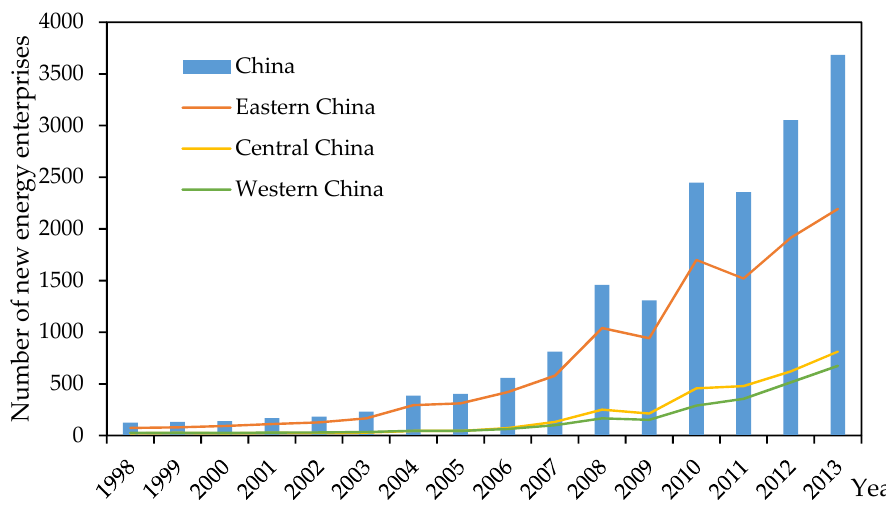
Figure 2. Number of new energy enterprises in China from 1998 to 2013. Based on sample data, we explored the spatial distribution characteristics of the five driving factors across China in 2013 (see Figure 3). There are significant regional disparities in these factors. (1) Enterprise scale ( FS ). According to the Statistical Standards for the Classification of Large, Medium, Small and Micro Enterprises, industrial enterprises with employees between 300 and 1000, and revenue between 20 and 400 million RMB belong to medium-sized enterprises. However, this paper only used the average main business income to indicate enterprise scale. Figure 3 shows that the average size of enterprises in most provinces is medium-sized, except for Tianjin, Jiangsu, Shaanxi, Jiangxi and Guangxi, where the average main business income is over 400 million RMB. Although these enterprises are large- and medium-sized according to the standards, the enterprise scale in different provinces still varies greatly. (2) Enterprise ownership structure ( SO ). The proportion of state-owned economic components in the NEI varies significantly among provinces. The provinces with a relatively low proportion of state-owned economy are mainly concentrated in the eastern coastal region and several provinces in the central region. The provinces with more than 50% of state-owned content are Gansu, Hunan, Shaanxi, and Yunnan. (3) Technological progress ( TE ). China’s R&D investment increased from 48.57 billion RMB in 1998 to 880.59 billion RMB in 2013, with an average annual growth rate of 21.3%. However, compared with developed countries, China’s R&D investment is still very low. In 2013, the RDI was very low for all provinces (less than 3.56%), except for Beijing (5.98%). Moreover, the provinces with higher RDI are mainly concentrated in the southeast coast and some provinces of the central region. (4) Economic development ( PGDP ). Regional disparity is a specific feature of China’s rapid economic development over the last few decades. The eastern region is the most developed, and the degree of development decreases from east to west. (5) New energy resources ( NE ). China is a vast country and rich in new energy resources. According to China Electric Power Yearbook [57], China’s total new energy power generation was 258.5 billion kWh in 2013, of which 111.5 billion kWh was from nuclear power, 138.3 billion kWh from wind power, and 8.4 billion kWh from solar power. However, the distribution of new energy resources in China is uneven with obvious spatial disparity. The three northern regions, including northwest (Xinjiang, Ningxia, Qinghai, and Gansu), northeast (Heilongjiang, Jilin and Liaoning) and north China (Inner Mongolia, Hebei and Shanxi), have the most